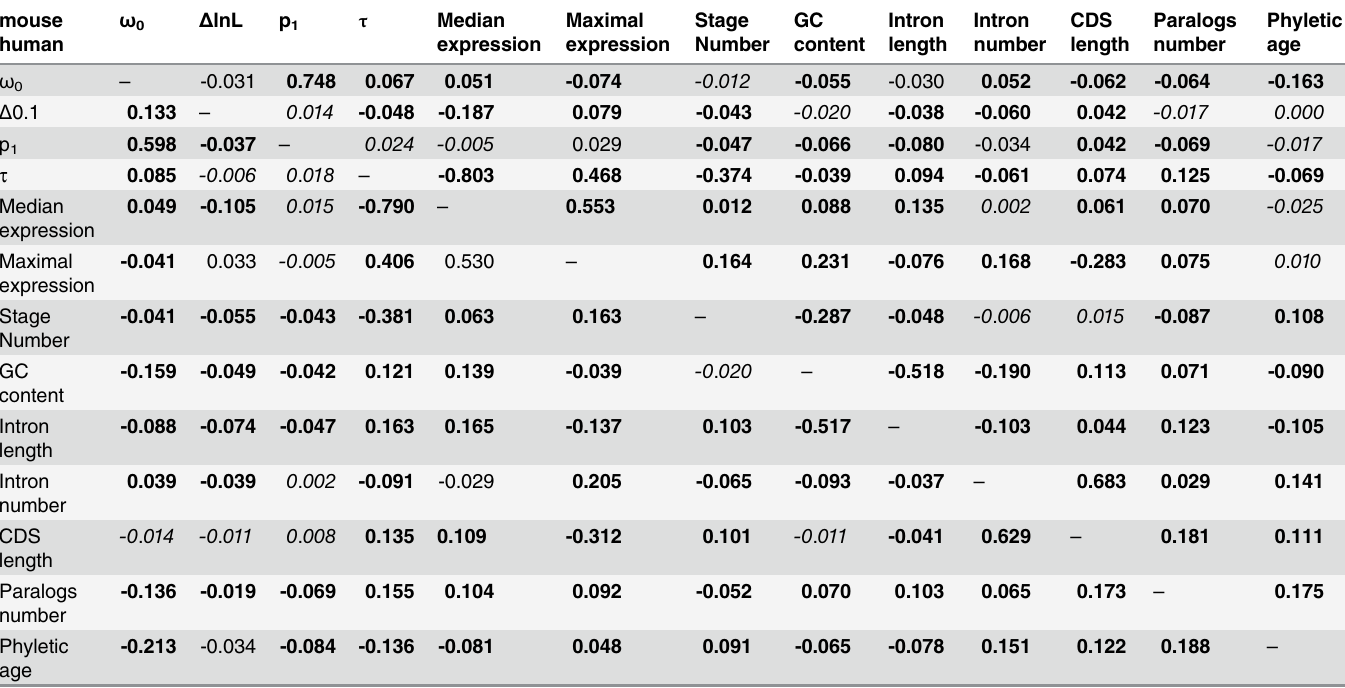
Table 1. Values of partial Spearman correlations between parameters, over all tissues.